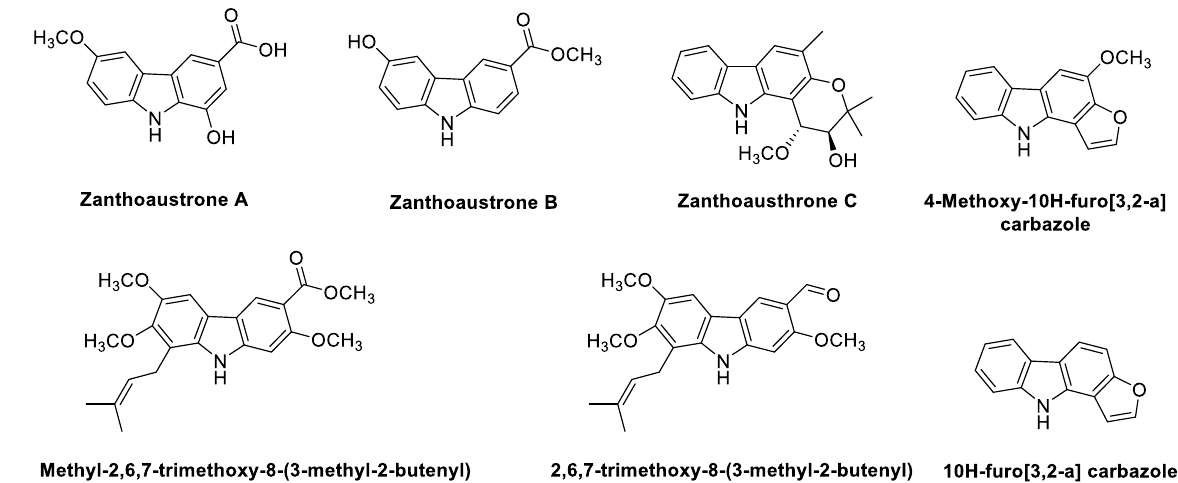
Figure 6. Potential neuroprotective phyto-carbazole alkaloids from the species of the genus Zanthoxylum .